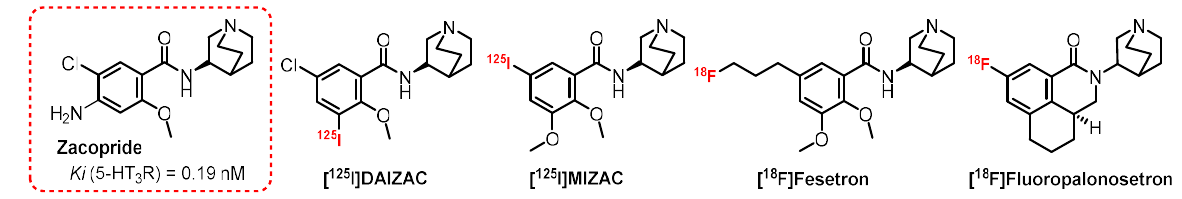
Figure 12. Zacopride derivatives as 5-HT 3 R radiotracers.